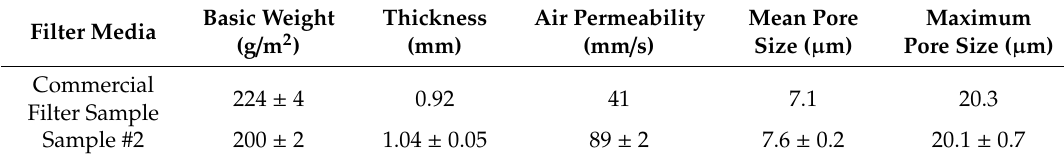
Figure 10. SEM images of commercial filter media. Table 4. The performance of commercial filter medium and sample #2. Table 4. The performance of commercial filter medium and sample #2.